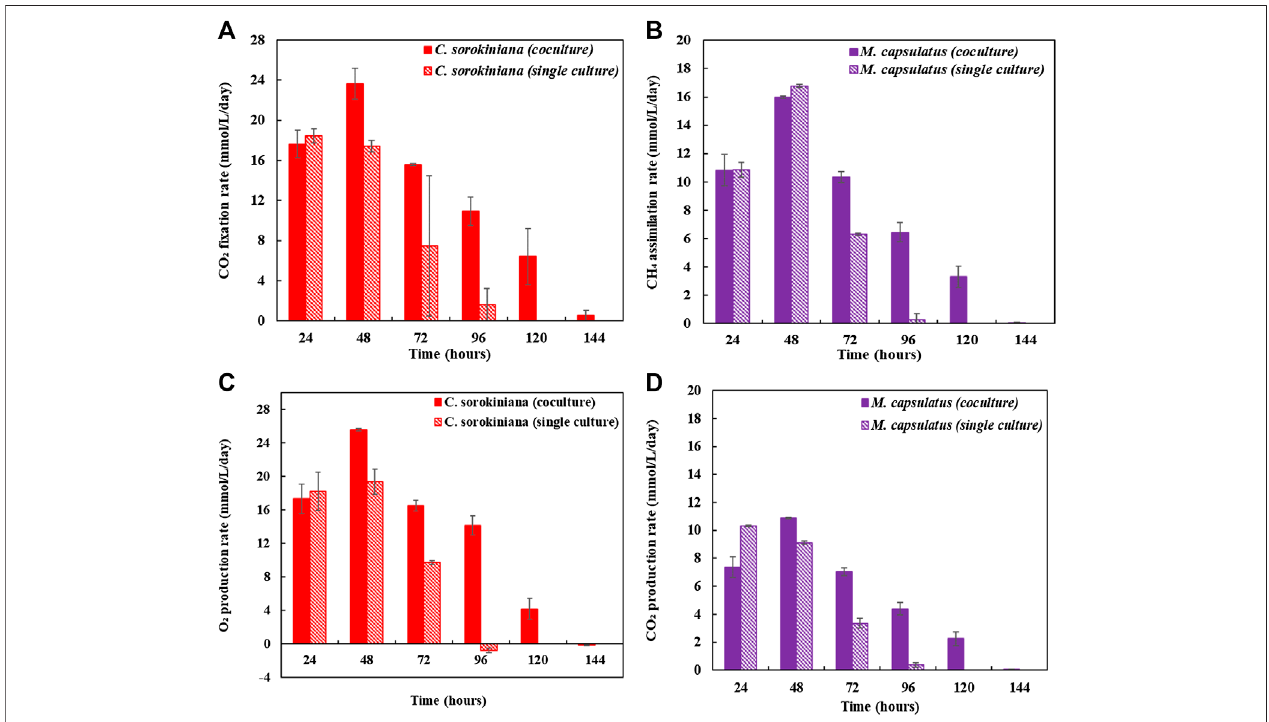
FIGURE10 |(A) CO 2 fi xation rate of Chlorella sorokiniana in coculture compared with thatofmicroalgae single culture, (B) CH 4 assimilationrate of Methylococcus capsulatus in the coculture compared with that of methanotroph single culture, (C) O 2 evolution rate of C. sorokiniana in coculture compared with that of microalgae single culture, and (D) CO 2 production rate of M. capsulatus in the coculture compared with that of methanotroph single culture.